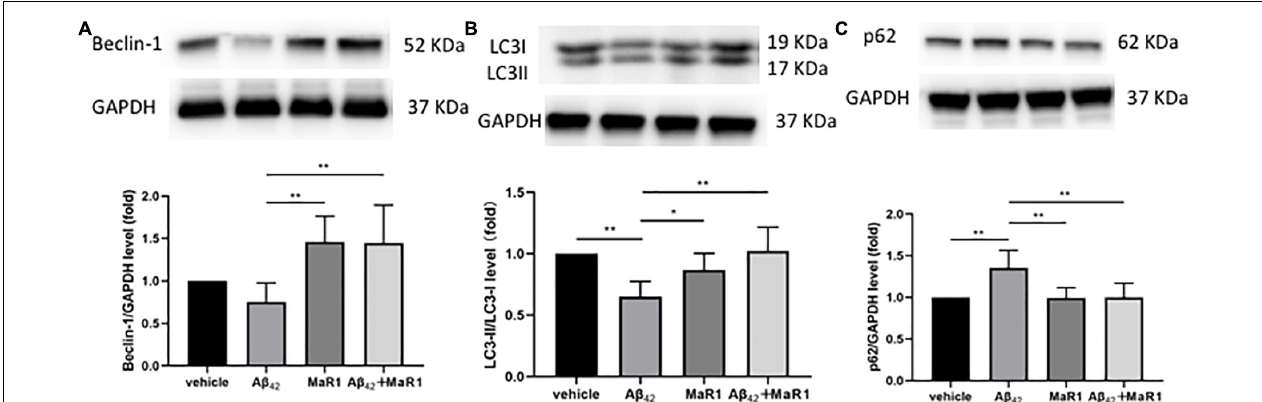
FIGURE 6 | MaR1 altered autophagy signal pathways. Compared with MaR1 group, the level of Beclin-1 (A) was decreased in A β 42 group ( P < 0.01), and increased by A β 42 + MaR1 treatment ( P < 0.01). Compared with Vehicle and MaR1 group, the ratio of LC3-II/LC3-I (B) was down-regulated ( P < 0.01, P < 0.05=, while the levels of p62 (C) was up-regulated in A β 42 group ( P < 0.01), however, these A β 42 induced changes were reversed by A β 42 + MaR1 treatment ( P < 0.01). Data are expressed as mean ± SEM, 10 mice in each group, and statistical significance is defined as follows: ∗ P < 0.05, ∗∗ P < 0.01.